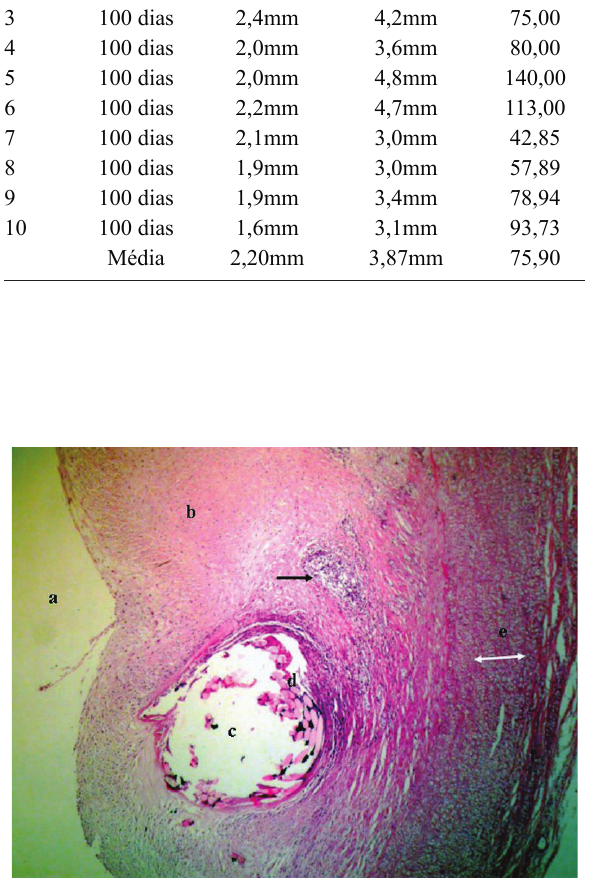
Fig 8 - Corte transversal da parede aórtica de suíno com concentração de células inflamatórias: a) luz da aorta;